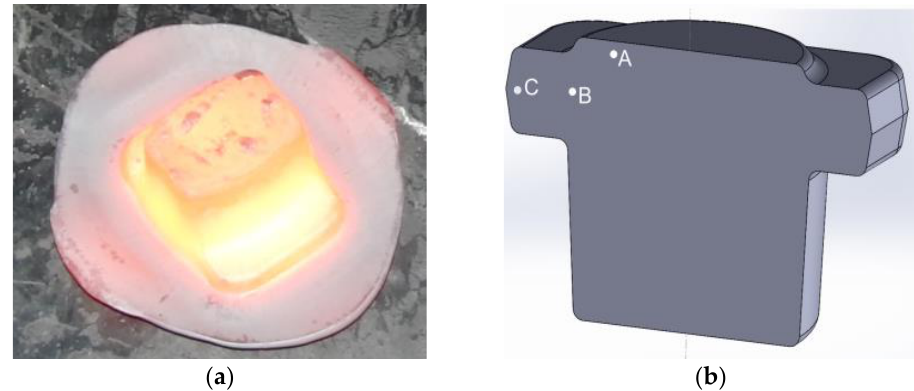
Figure 6. The flange forged on hammer ( a ), the flange model with areas of metallographic investi- gations marked ( b ). A, B, C – areas of metallographic observations on the forged part cross-section.